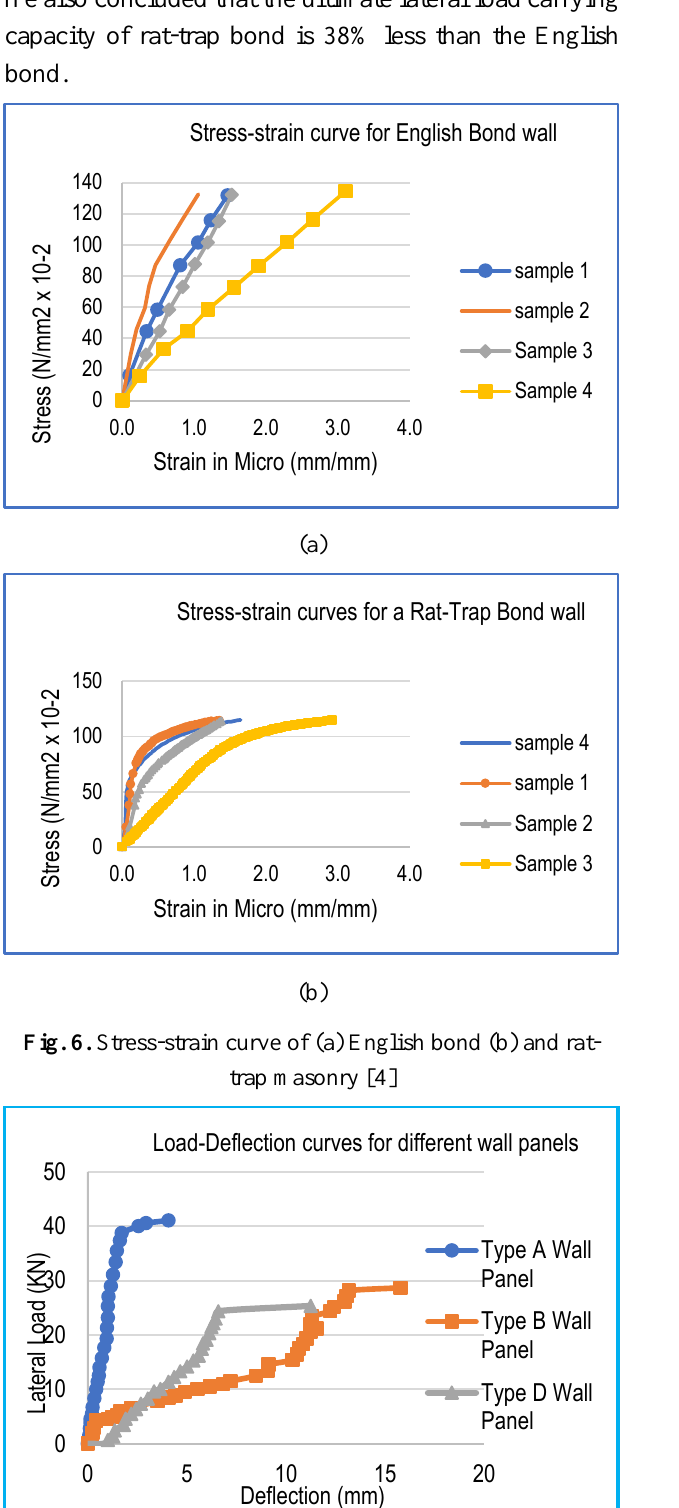
Fig. 7. Load-Deflection for different wall panels at the top